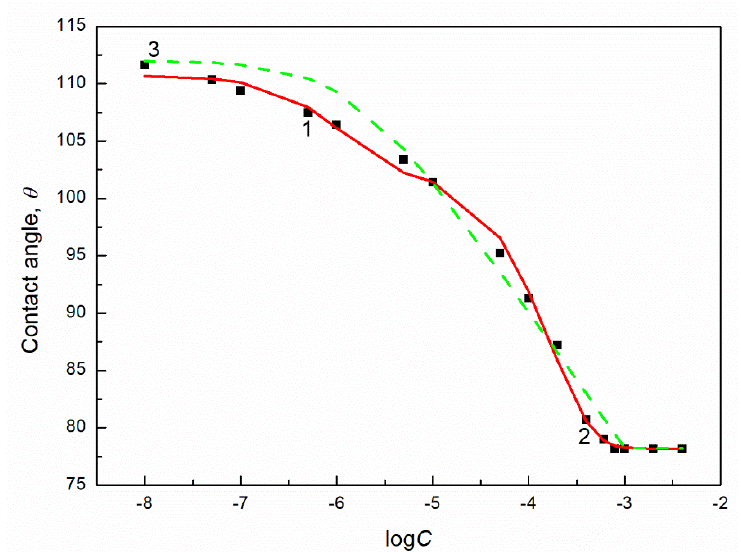
Figure 1. A plot of the TX165 aqueous solution contact angle ( θ ) on PTFE (curves 1–3) vs. the logarithm of TX165 concentration ( C ). Curve 1 corresponds to the measured values, curve 2 to values calculated from the exponential function of the second order: θ = 24.66595 exp( −𝐶 ) + 7.90722exp( −𝐶 ) + 78.1891) , 0.000170057 0.0000011843 curve 3 corresponds to the values calculated from Equations (9) and (11), respectively.